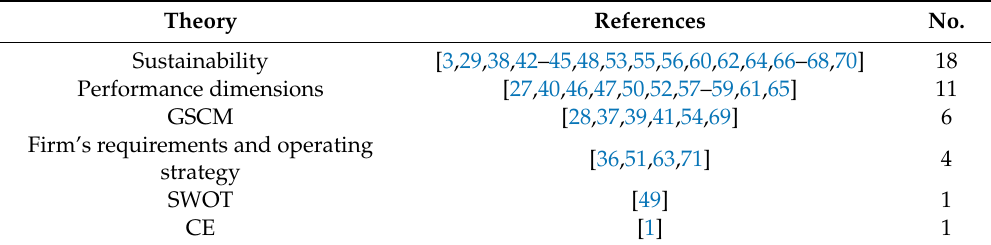
Table 6. Theory of criteria